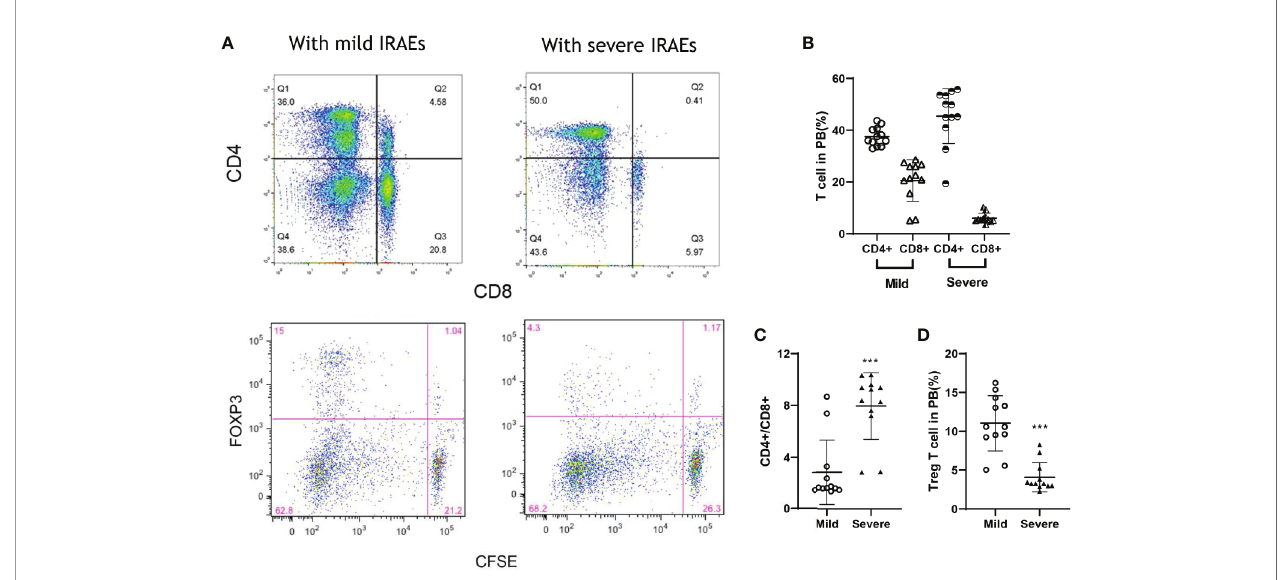
FIGURE 4 | FOXP3+ and CD4+/CD8+ T cells were associated with IRAEs during anti-CTLA4 immunotherapy. (A) The population of CD4+, CD8+, and FOXP3+ T cells after the intervention of ipilimumab. (B, C) The population of T cells (B) and Treg cells (C) in peripheral blood of mice with IRAEs or not. (D) The ratio of CD4+/CD8+ T cells in peripheral blood of the HPDOX mice with IRAEs and not. There were twelve mice in each group. Data were represented as mean ± SD. *** P < 0.001.